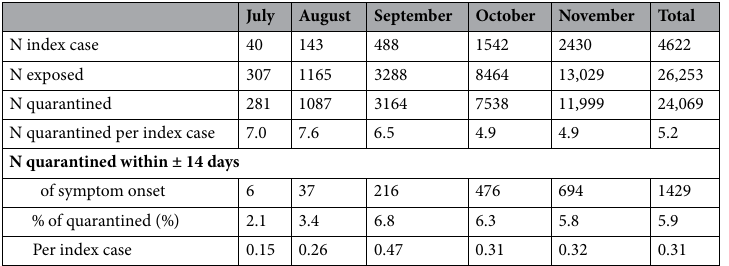
Table 2. Exposed contacts. The table reports data for the 26,253 exposed contacts with Helsinki residence (the total number of exposed contacts was 31,837; see text). For each month, the table shows the number of index cases, exposed contacts, exposed individuals that were quarantined and their proportion per index case, and the number and proportion of quarantined that are identified as infected within ± 14 days of quarantine onset. In addition, the last line shows the number of exposed contacts that are identified as infected within ± 14 days of quarantine onset, per index case.